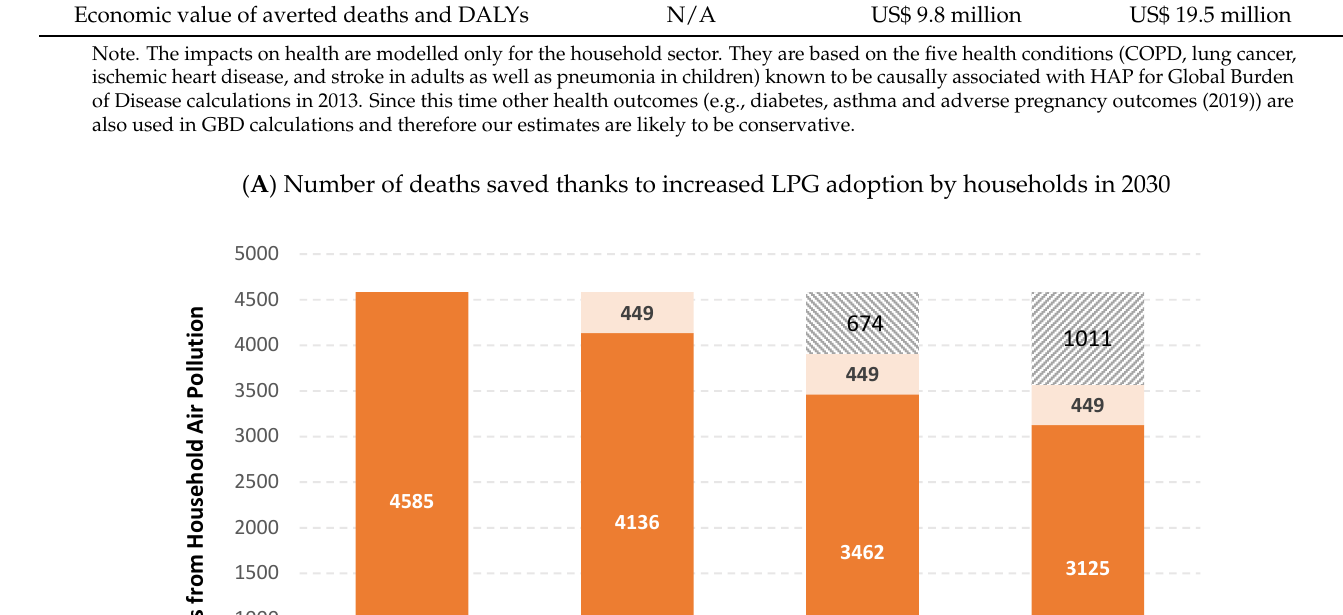
12 of 20 Table 3. Cumulative health impacts of projected LPG adoption for each of the scenarios